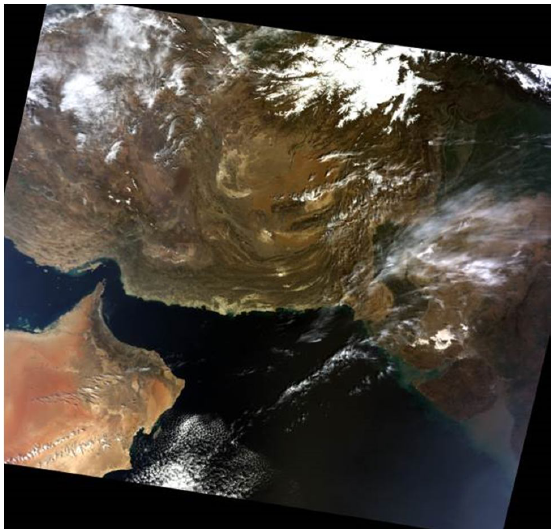
Figure 1. Test area (R: band 1, G: band 4, B: band